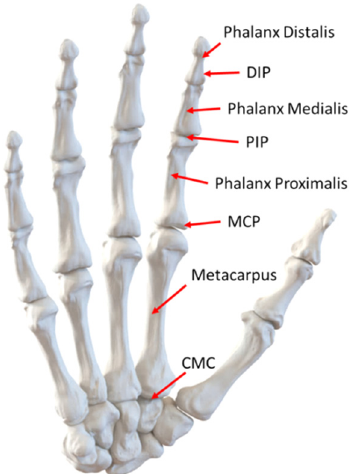
Figure 1. A scheme of bones and joints in a human hand.